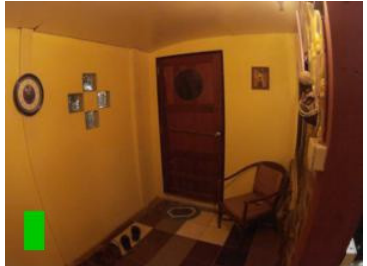
Figure 4. “Filled rectangle”.